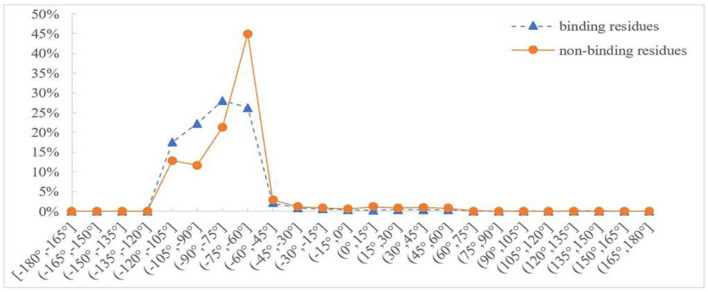
Distribution of phi angle for binding and nonbinding residues of Mn2+ ligand. The abscissa represents 24 classification intervals; the ordinate represents the percentage of predicted phi angle that appears in each interval.